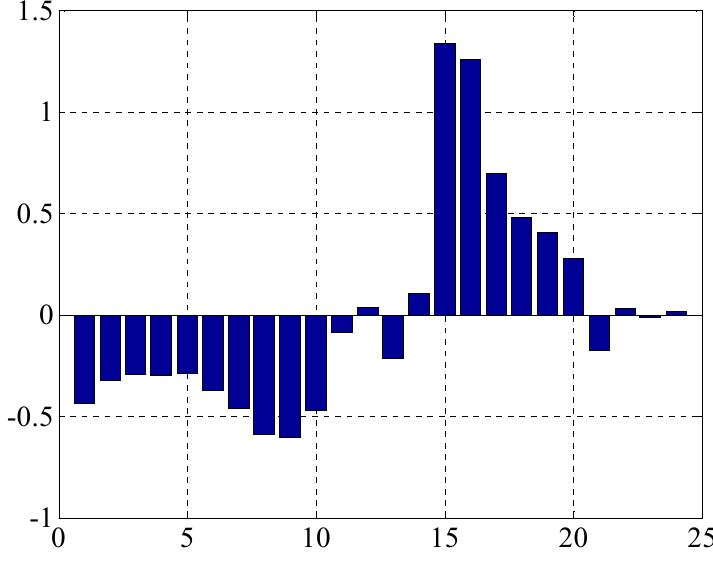
Figure 27. The performance index PAI 1 of 1# boiler combustion control for one day.